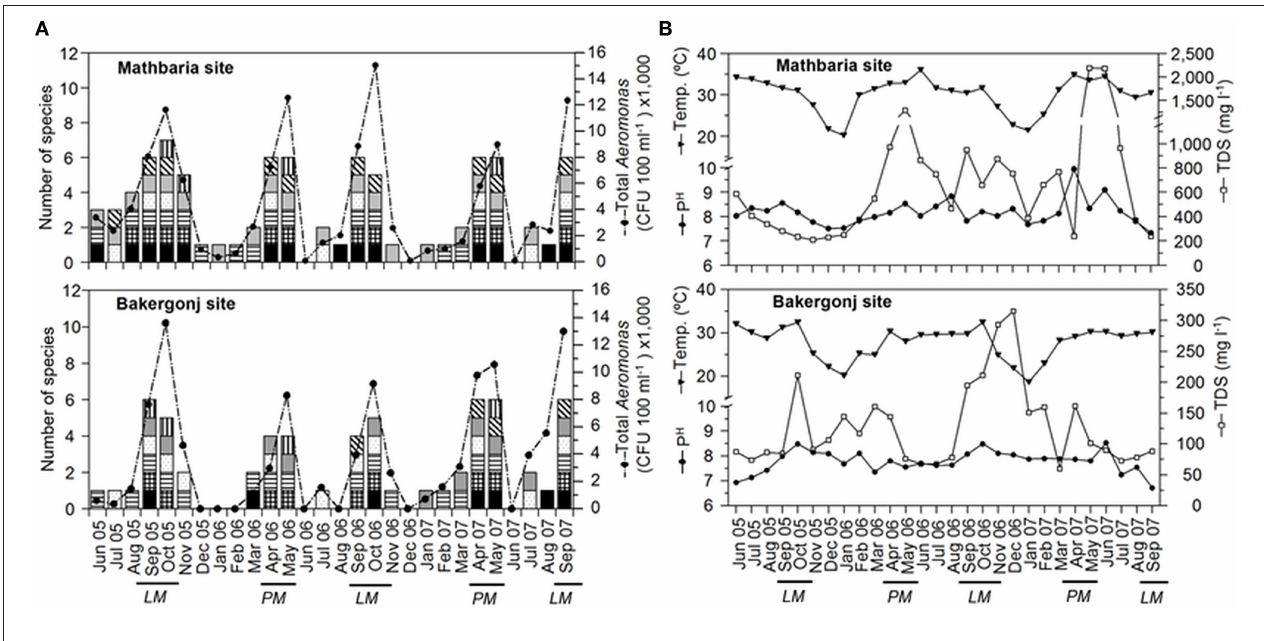
FIGURE 2 | Dynamics of Aeromonas populations and physicochemical variables in pond waters in the coastal zone of Bangladesh. (A) Changes in total cultivable populations shown as line graph and species diversity, shown as stacked columns, in Mathbaria (top panel) and Bakergonj (bottom panel) sites of coastal Bangladesh. Individual species are demarcated in the stacked columns as: A. veronii bv. sobria (